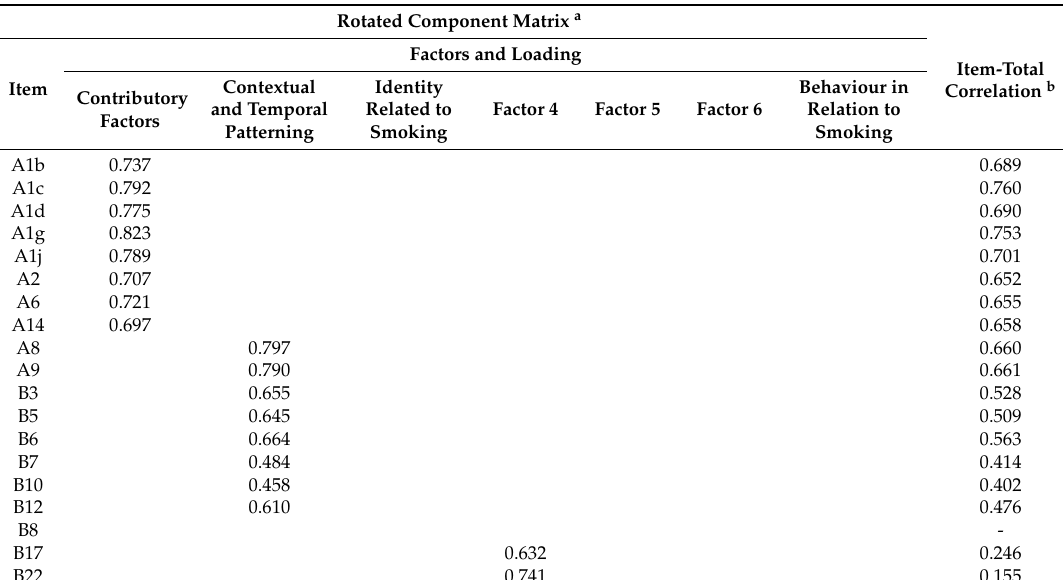
Table 9. Exploratory factor analysis (repeated